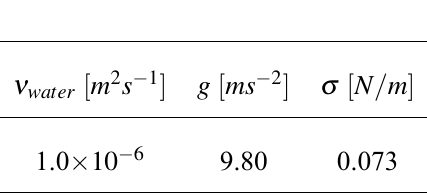
Physical properties of the